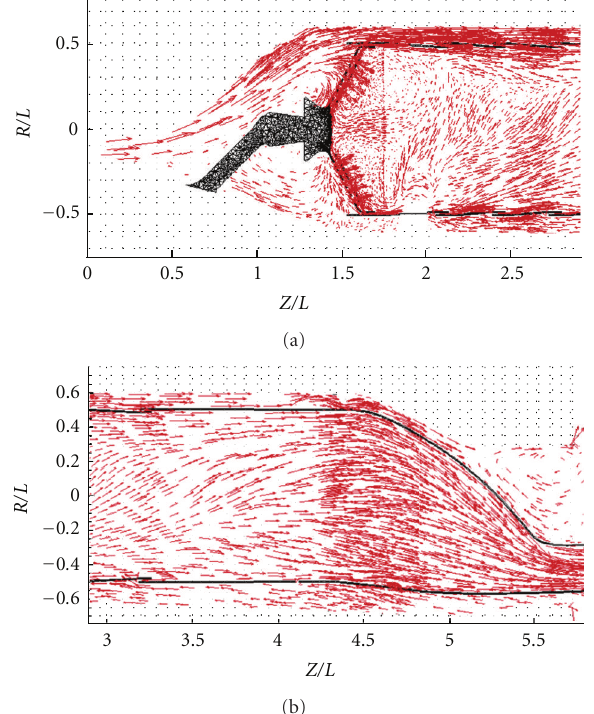
Figure 5: Velocity vector plots along the middle longitudinal plane.